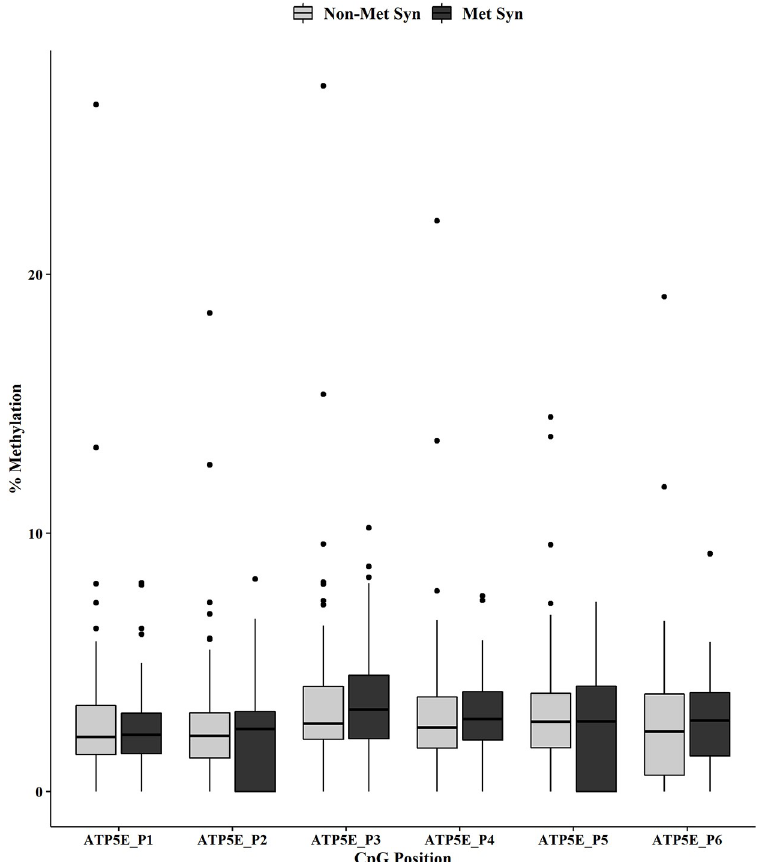
Fig 1. ATP5E promoter DNA methylation by MetS status. DNA methylation at six CpGs within the promoter of ATP5E was measured in non-MetS (n = 110) and MetS (n = 74). Mann-Whitney U test was used for the statistical comparisons between the non-MetS versus